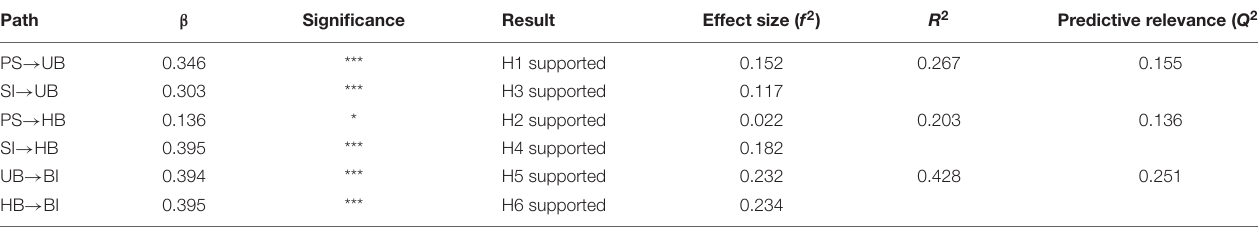
TABLE 6 | Outcome of the structural